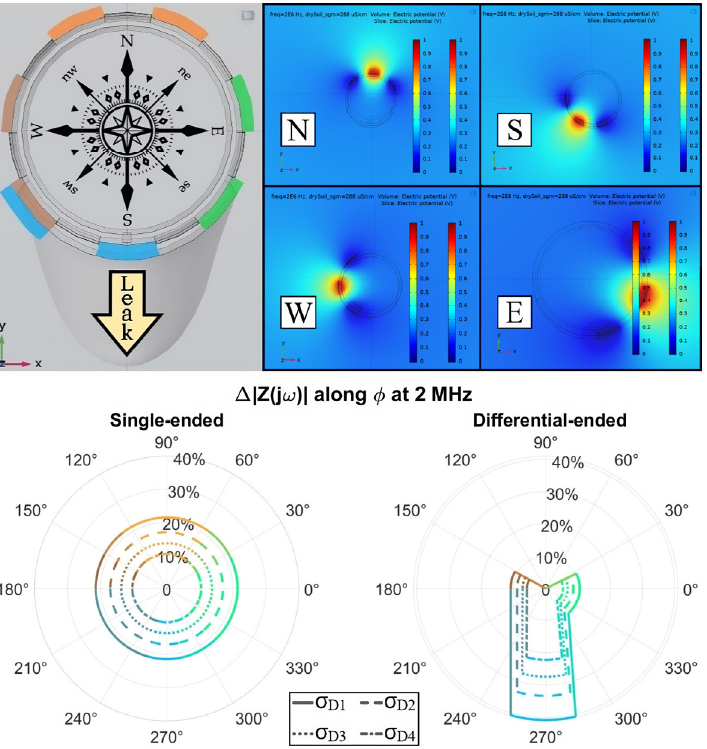
Figure 17. ( Top ) Sensor frontal view with electrodes subdivided into triplets and their respective F.E.M. simulations, unused metal strips being absent in the latter; ( Bottom ) Both single-ended and angular differential emulated readouts are shown following the predefined color pattern, with four distinct electrical “dry soil” conductivities ( σ D4 > σ D3 > σ D2 > σ D1 ) mimicking a common-mode humidity homogeneously scattered within the terrain and degrading the system’s sensitivity to a leak.